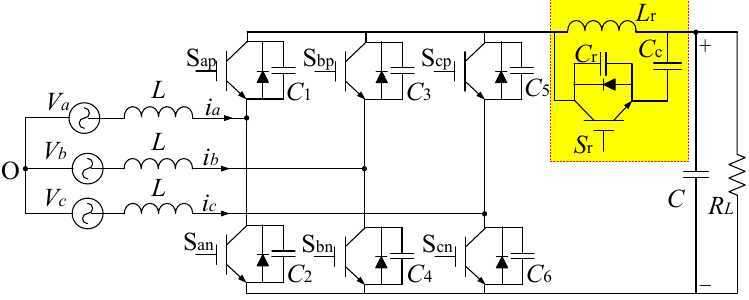
Figure 1. Compound active clamp ZVS three-phase VSR circuit.